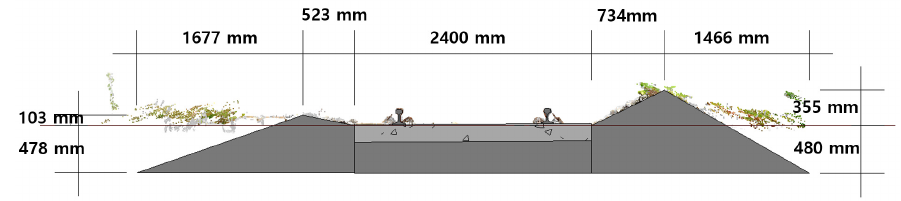
Figure 12. Ballast shoulder width and ballast shoulder fill of sleeper (1) review.